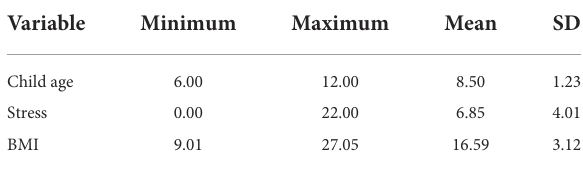
TABLE 2 Mean and standard deviation of other variables among the studied